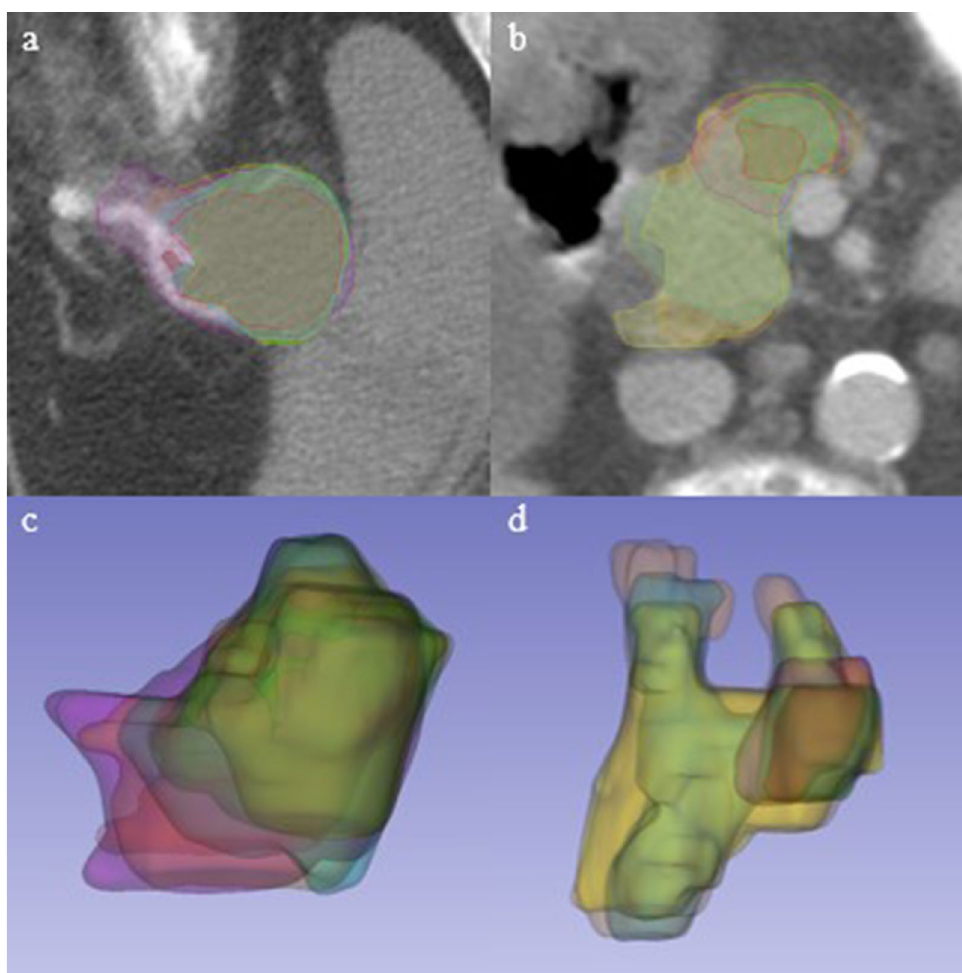
Figure 1. Visualization of contours drawn by all 6 observers. 2D and 3D views of patients with high volume agreement ( a , c ) and low agreement ( b , d